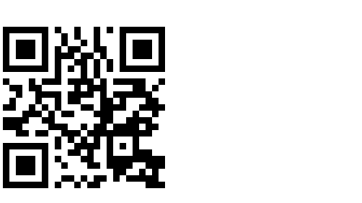
Table 2. Characteristics of digital models.